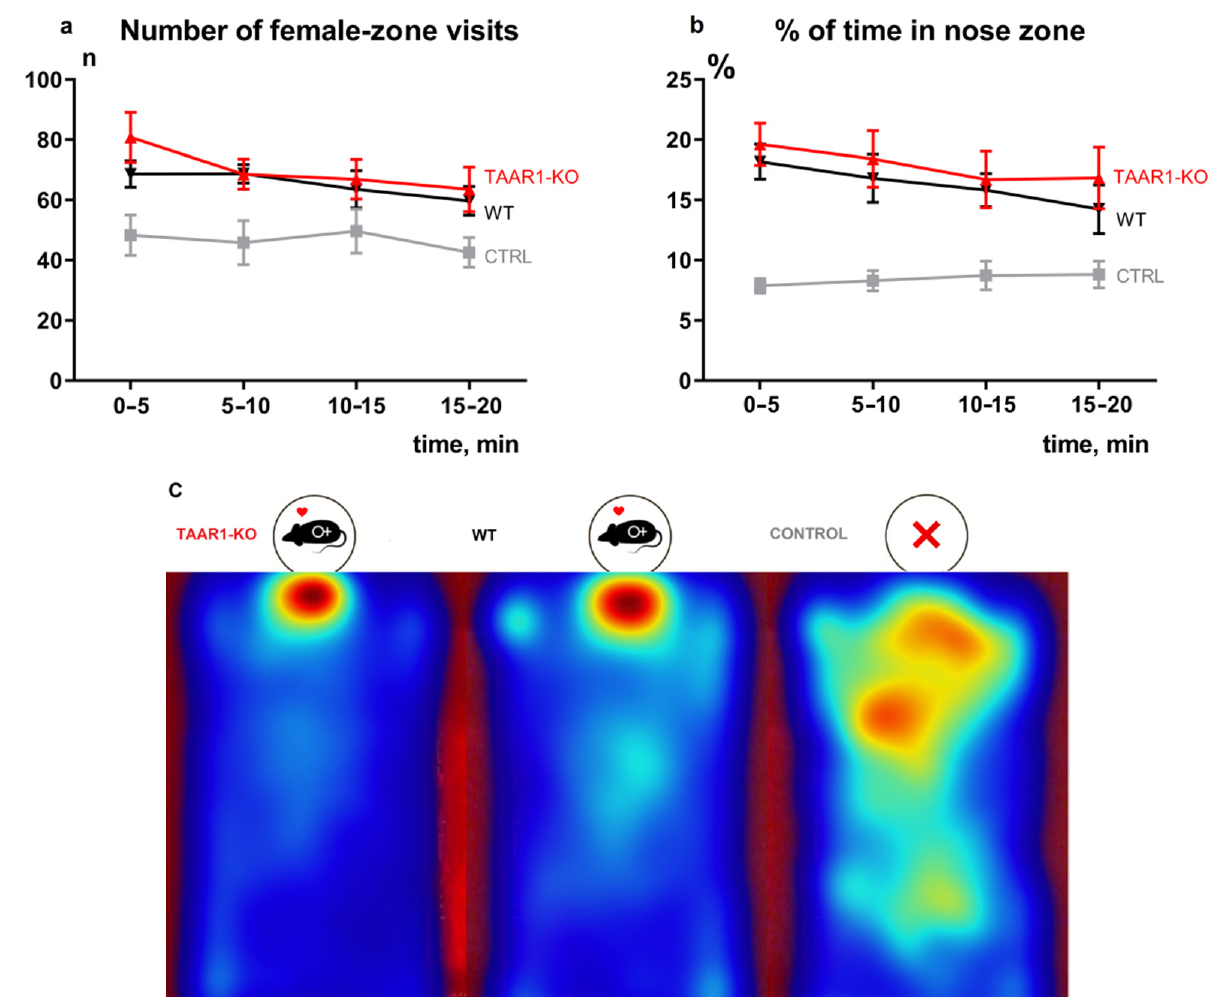
Figure 2. SIMT behavior parameters panel for TAAR1-KO and WT mice. No alterations in sexual incentive behavior in TAAR1-KO male mice in the SIMT test. ( a ) There are no significant differ- ences in the number of visits to the female zone ( b ) and the percent of the time in the nose zone between WT and TAAR1-KO mice. All other behavioral parameters also revealed minimal altera- tions. Additionally, the behavior of control groups (CTRL) without female mice in chambers demonstrates the effectiveness of the adapted method. ( c ) represents the average heatmap visual- ization of the nose-point track. Control mice mostly demonstrate locomotor and exploratory activ- ity over the whole cage compared to other groups. Full graphics are presented in Supplementary Materials. Data are mean ± SEM.